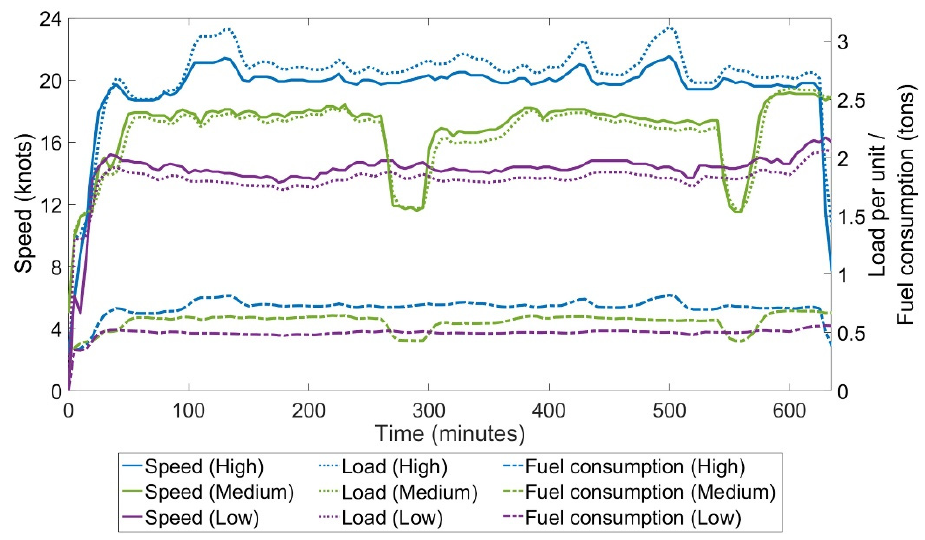
Figure 7. Baseline data of all selected operation profiles.